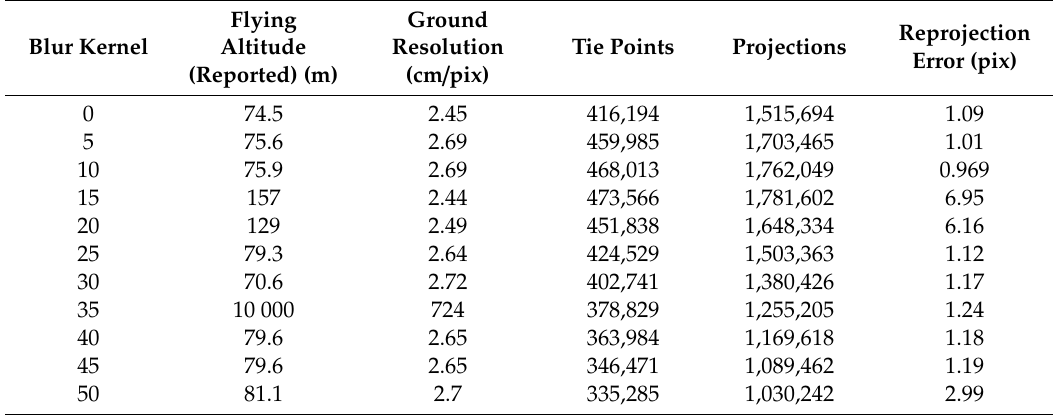
Table 2. Reported survey data for blurred dataset.